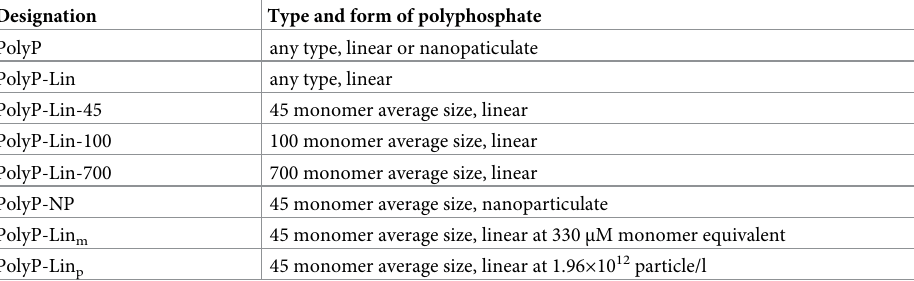
Table 1. Designations of polyphosphates used in this